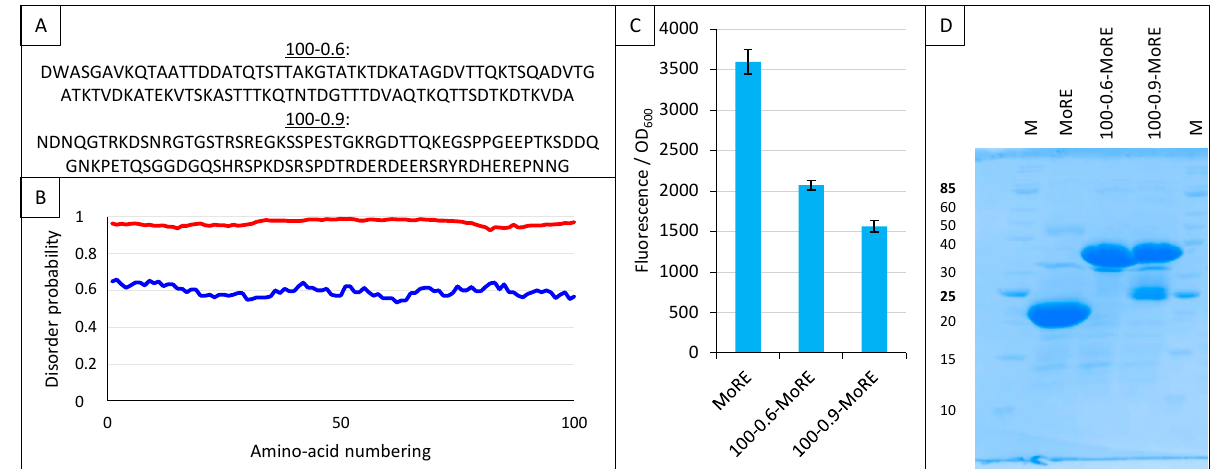
Figure 14. Split-GFP reassembly assay and artificial disordered proteins. ( A ) Amino acid sequence of the two artificial proteins 100-0.6 and 100-0.9. ( B ) Disorder probability of 100-0.6 (blue line) and 100-0.9 (red line), as assessed by IUPred [40] . ( C ) Fluorescence-to-OD 600 ratio (mean value and standard deviation of a triplicate experiment) of MoRE/XD, 100-0.6-MoRE/XD and 100-0.9- MoRE/XD pairs. ( D ) SDS-PAGE analysis of the expression of the NGFP fusions (His-NGFP-MoRE (24 kDa), His-NGFP-100-0.6MoRE (34 kDa), His-NGFP-100-0.9MoRE (34 kDa)) of C. M, molecular size markers (kDa).